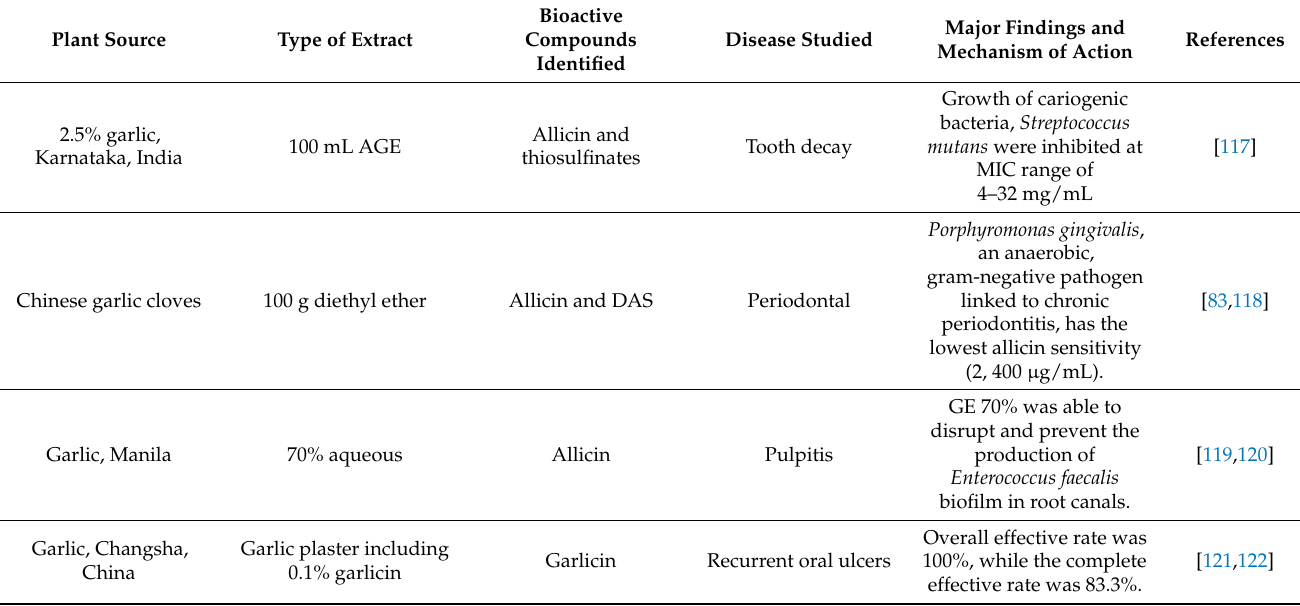
Table 3. Role of GE and its bioactive to alleviate oral